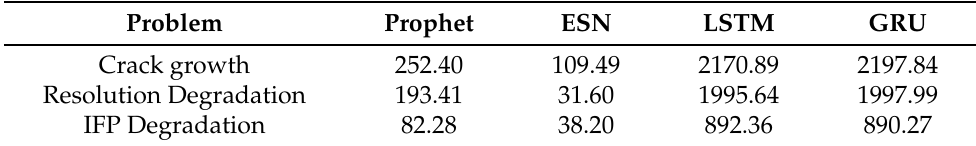
Table 3. Time performance measured in